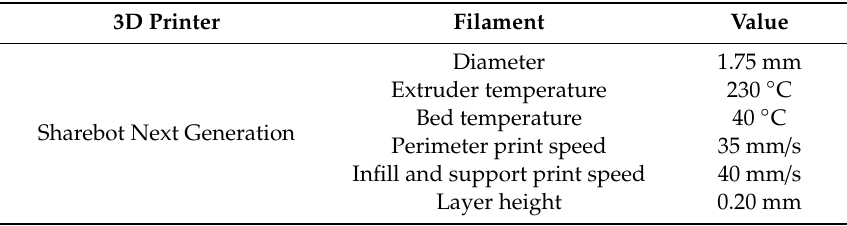
Table 3. 3D printing process parameters.